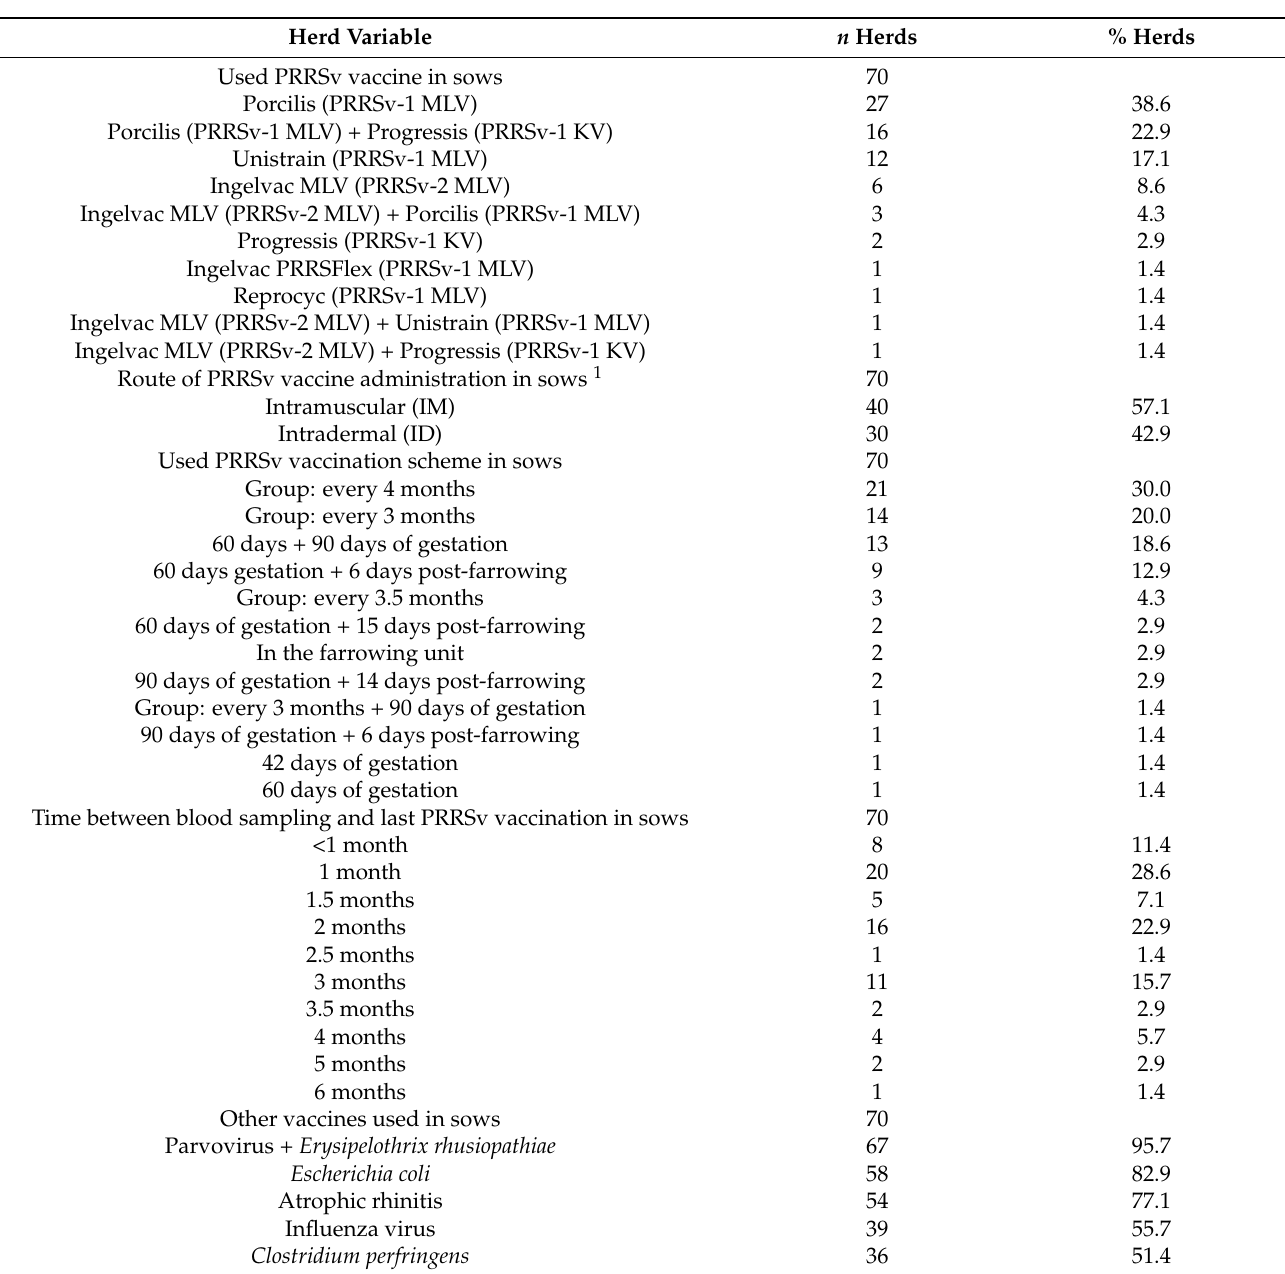
Table 2. Categorical data related to sow, gilt and piglet vaccination management in the selection of 70 Belgian sow herds that practice routine vaccination against Porcine Reproductive and Respira- tory Syndrome virus (PRRSv). Data were gathered by means of a PRRSv-specific questionnaire and were applicable to each farm for the period of 12 months prior to the farm visit. Data are shown as the number ( n ) and percentage (%) of herds having a certain herd